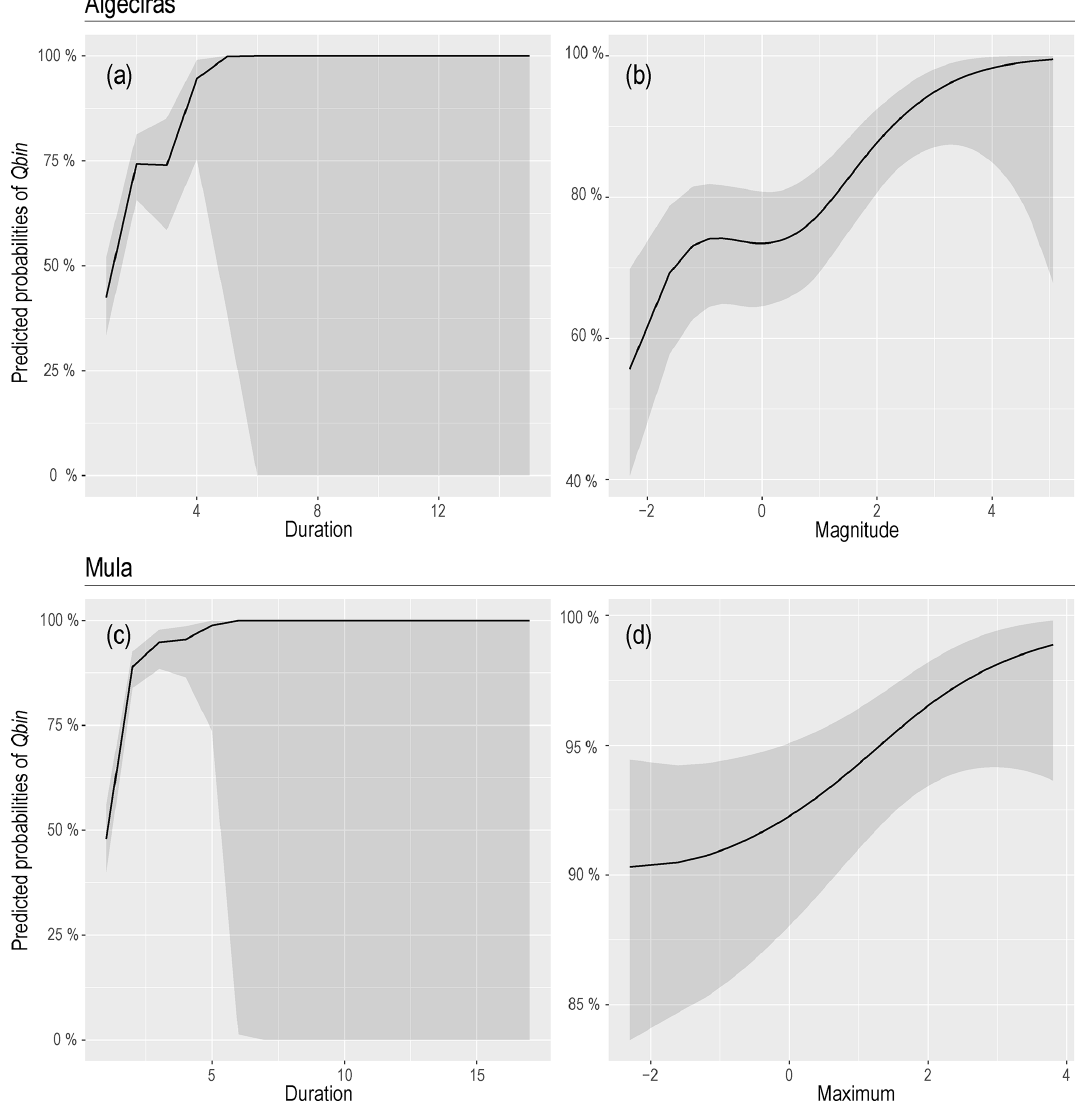
Figure 7. Predicted probabilities of partial effects of individual smooth terms of the model for Algeciras (a, b) and Mula (c, d) . Shaded areas show the 95% confidence intervals. Magnitudes and maximums are in logarithmic